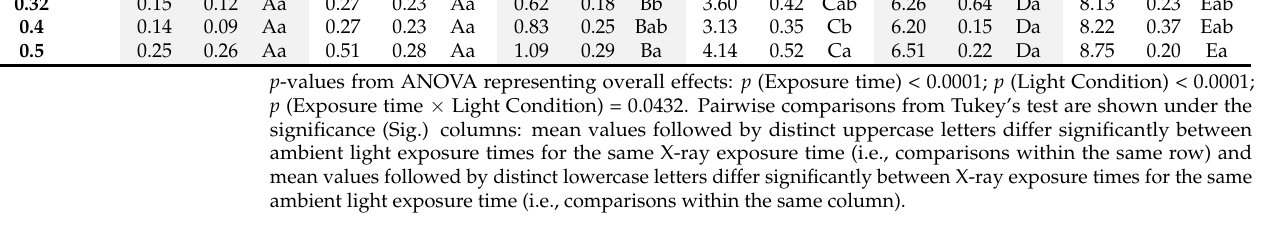
Table 4. Mean values, standard deviation (SD), and pairwise significance (Sig.) of contrast discrepancy as a function of light and X-ray exposure times for the Express system.